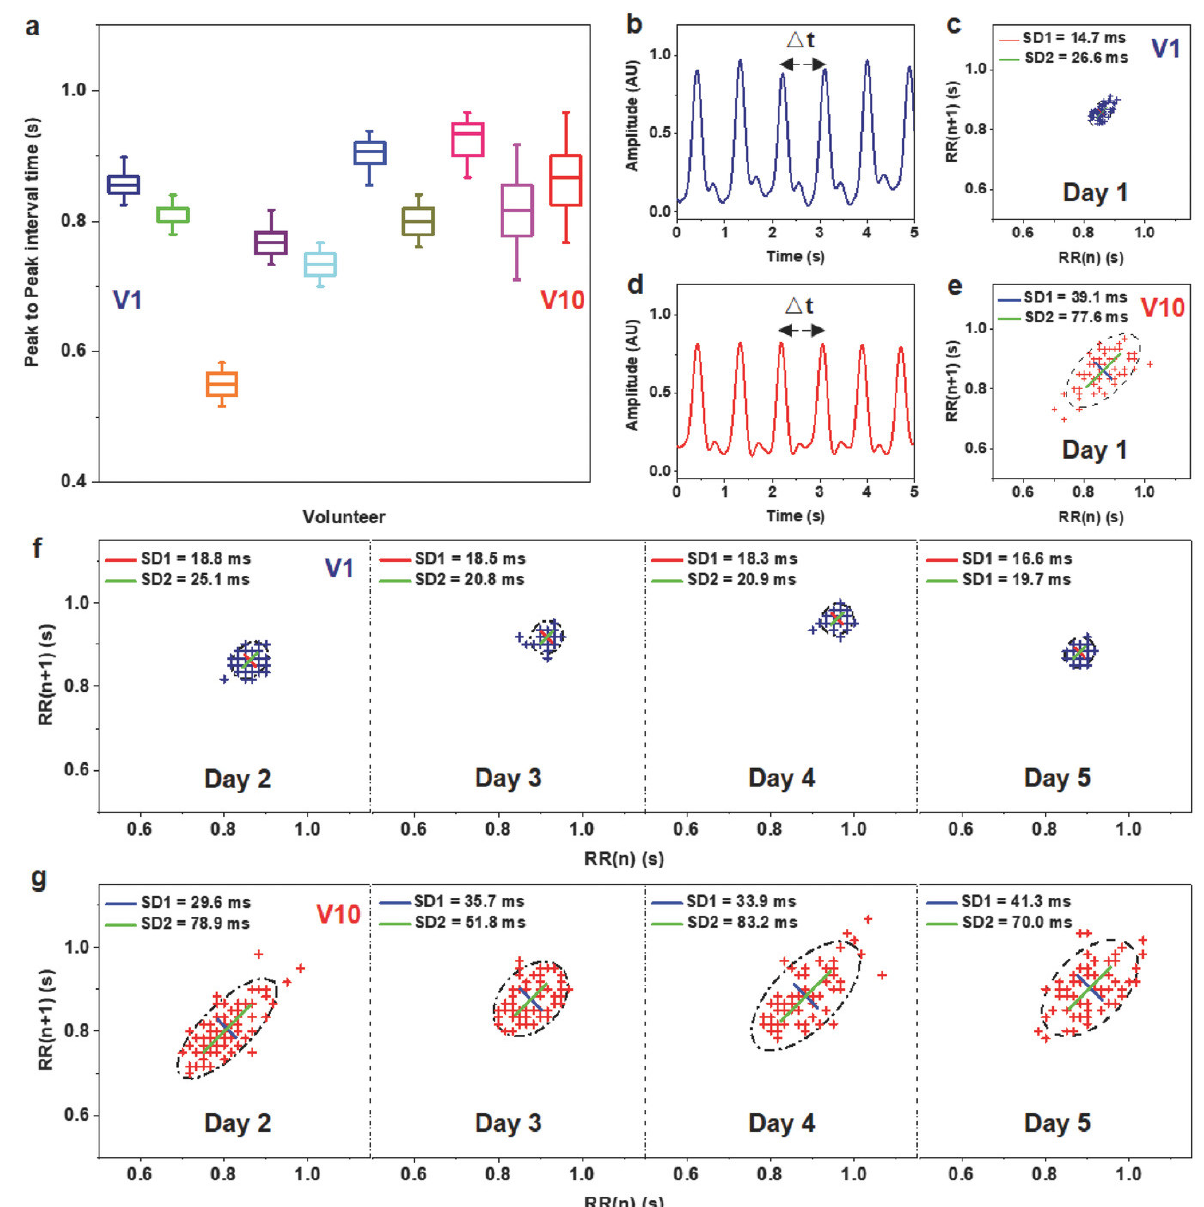
Figure 23. Results of the pulse-sensing system measured from ten volunteers [112]. ( a ) Statistical data of the peak-to-peak pulse wave intervals for the ten volunteers. The ninth and tenth volunteers (V9 and V10) have pulse intervals with larger dispersion compared to the other eight volunteers. It is due to the ninth and tenth volunteers having arrhythmia that was previously diagnosed using ECG tests in hospitals. ( b ) Amplitude of pulse waves and ( c ) corresponding Poincare plots for the first volunteer (V1), who was not diagnosed with arrhythmia. ( d ) Amplitude of pulse waves and ( e ) corresponding Poincare plots for the tenth volunteer, who has arrhythmia. Poincare plots for the ( f ) first and tenth ( g ) volunteers. The volunteer V10 has larger dispersion of pulse wave intervals. Large dispersion of the pulse wave intervals could be related to arrythmia disease. Reprinted with permission from [112]. Copyright ©2018, WILEY-VCH Verlag GMbH & Co. KGaA, Weinheim.